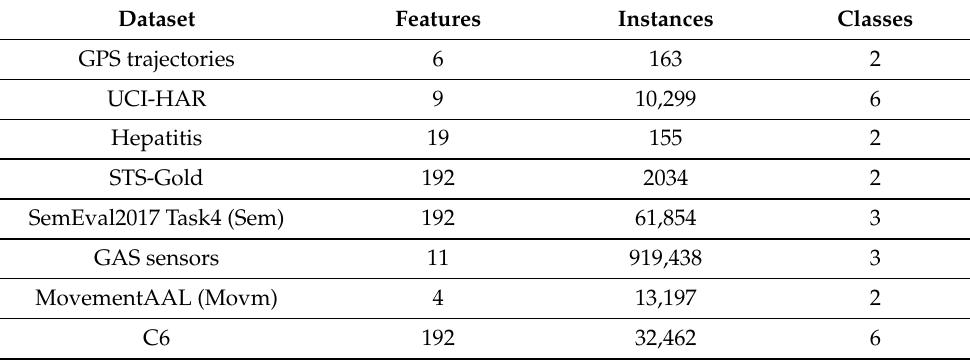
Table 8. The number of features and samples in each dataset.